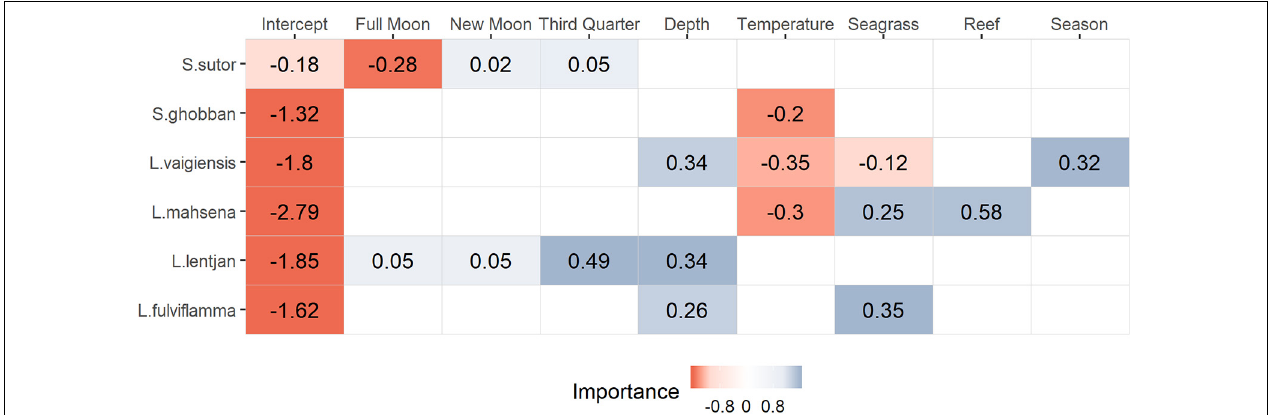
FIGURE 3 | Summary of the selected environmental drivers for each species and the value of the corresponding slope. The legend represents the probability of the slope (Importance) to be below (negative, red) or above (positive, blue) zero.